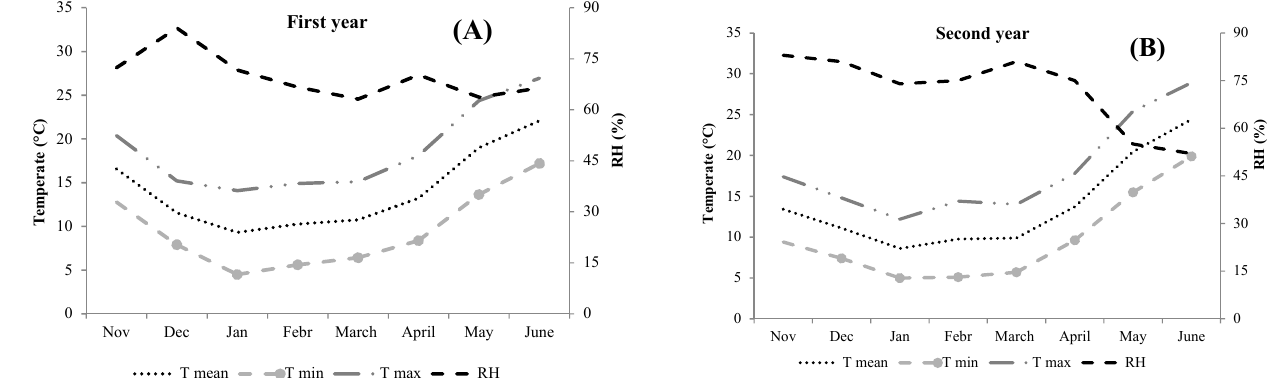
Figure 2. Mean air temperature, absolute minimum and maximum temperatures, and relative humidity (RH) for month during the first ( A ) and second ( B ) year of the durum wheat cycle.